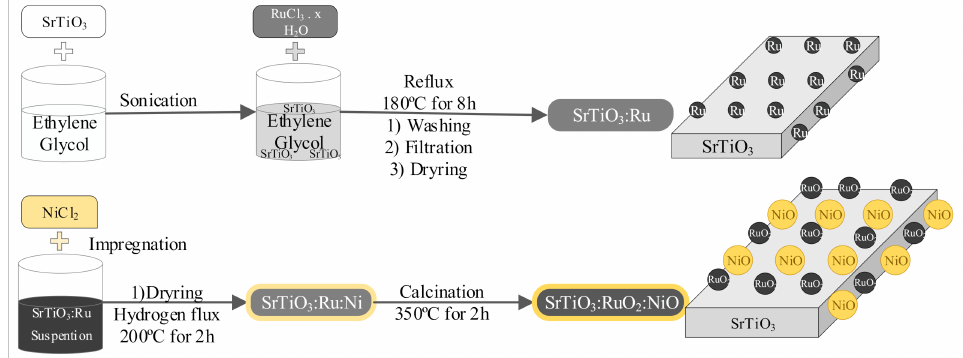
Figure 1. Schematic representation of the SrTiO 2 :RuO 2 :NiO photocatalyst preparation